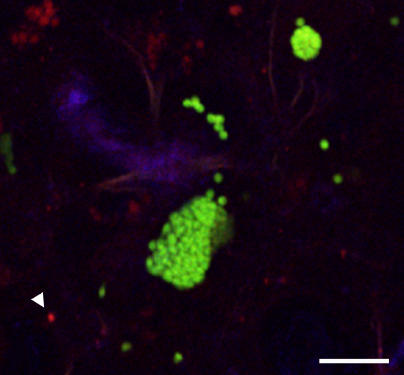
Pulmonary Merosomes Are ViableMouse lung analyzed ex vivo 48 h after infection with PyGFP. Generally, neither merosomes nor free merozoites incorporated intravenously injected PI indicating that the parasites were viable. Note that one of the merozoites is PI-positive (arrowhead). Nuclei were visualized by Hoechst staining (blue). Bar = 10 μm.